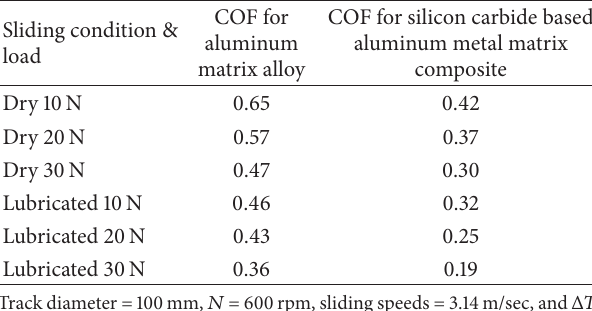
Table 3: Variation of coefficient of friction with load for aluminum matrix alloy and silicon carbide based aluminum metal matrix composite at 𝑉 = 3.14 m/sec.